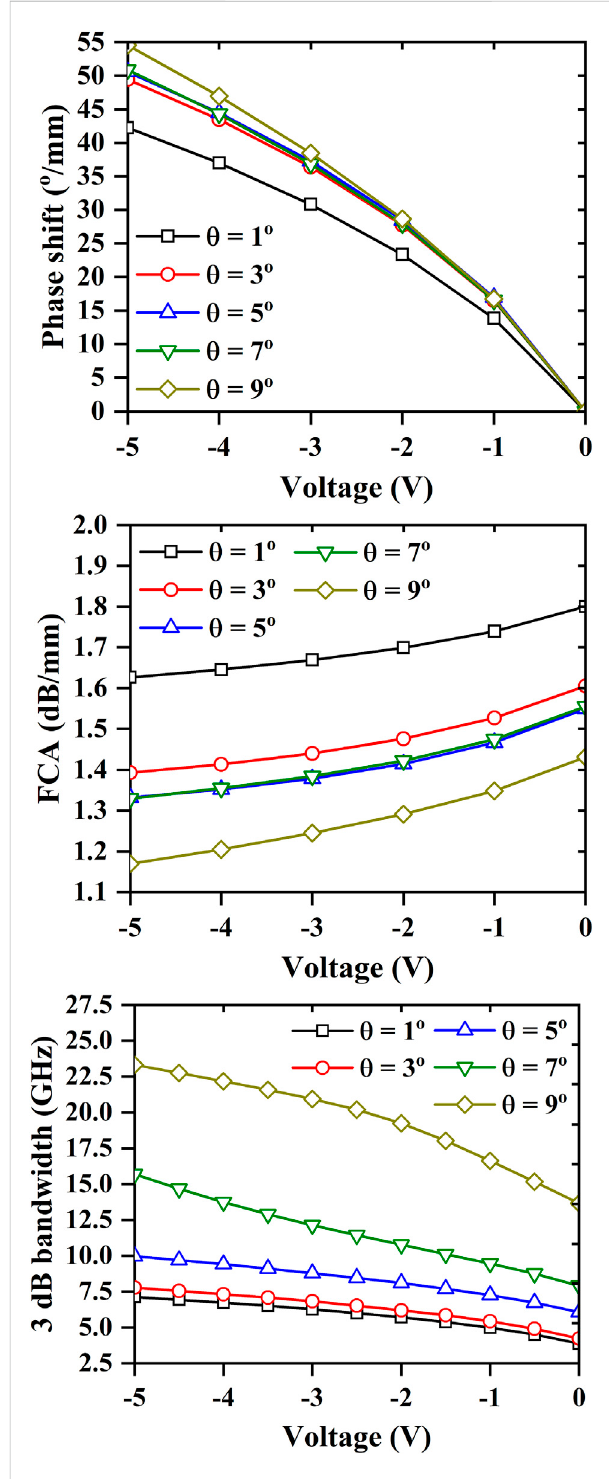
FIGURE 7 (A) Phase shift per unit length, (B) free-carrier absorption per unit length, and (C) 3-dB bandwidth for different wafer